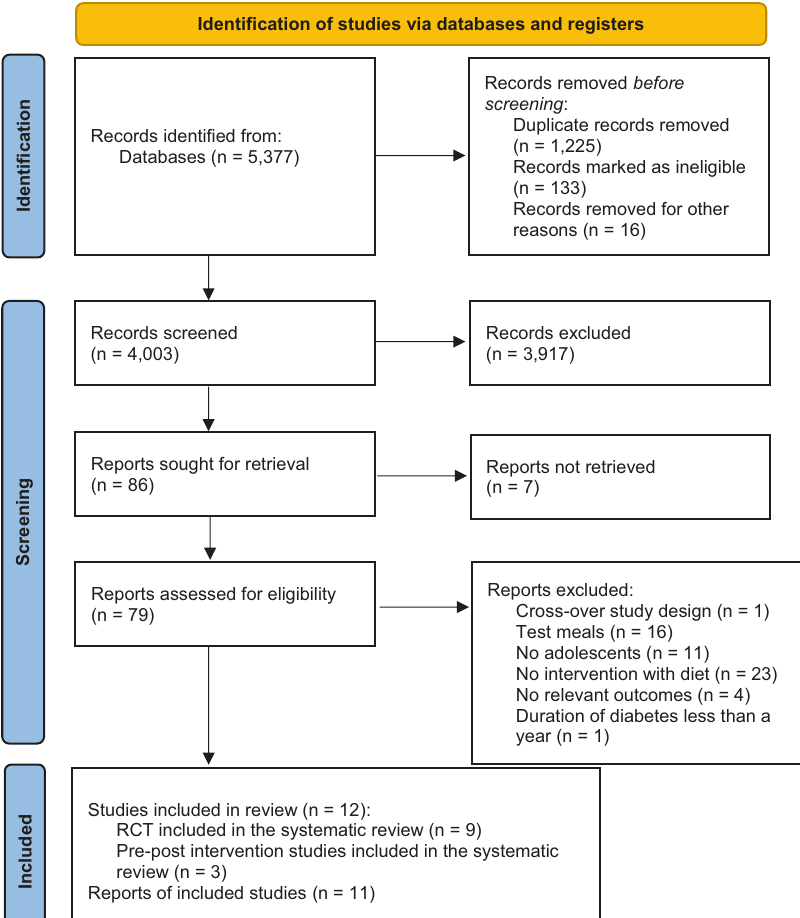
Fig. 1 PRISMA fl ow diagram of the study selection. RCT randomized clinical